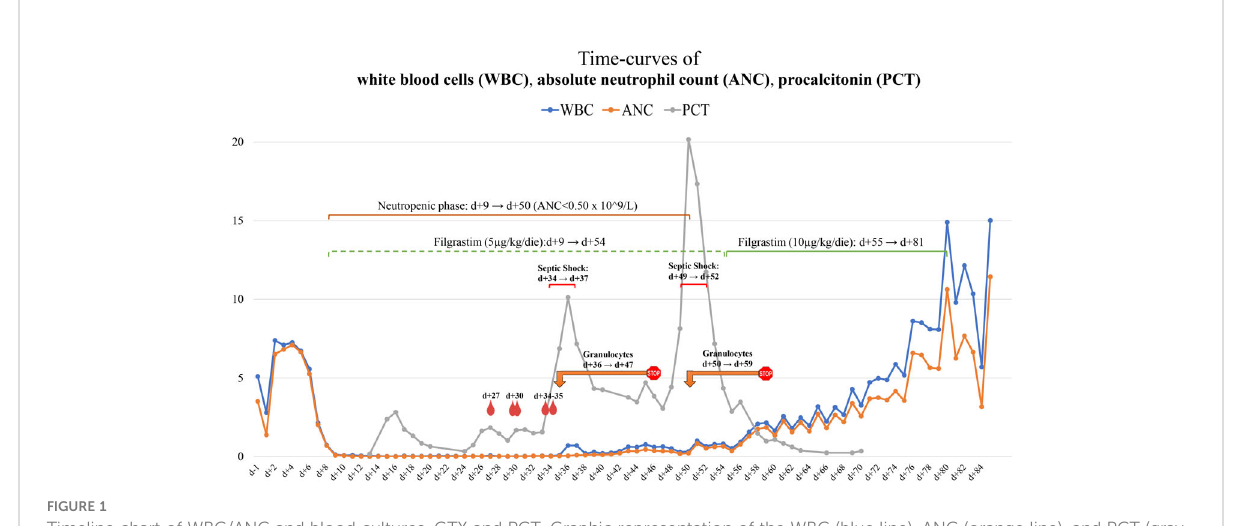
FIGURE 1 Timeline chart of WBC/ANC and blood cultures, GTX and PCT. Graphic representation of the WBC (blue line), ANC (orange line), and PCT (gray line) curves and their correlation with Saprochaete clavata isolation from blood cultures and GTX therapy. Hemocoltures positive for Saprochaete clavata